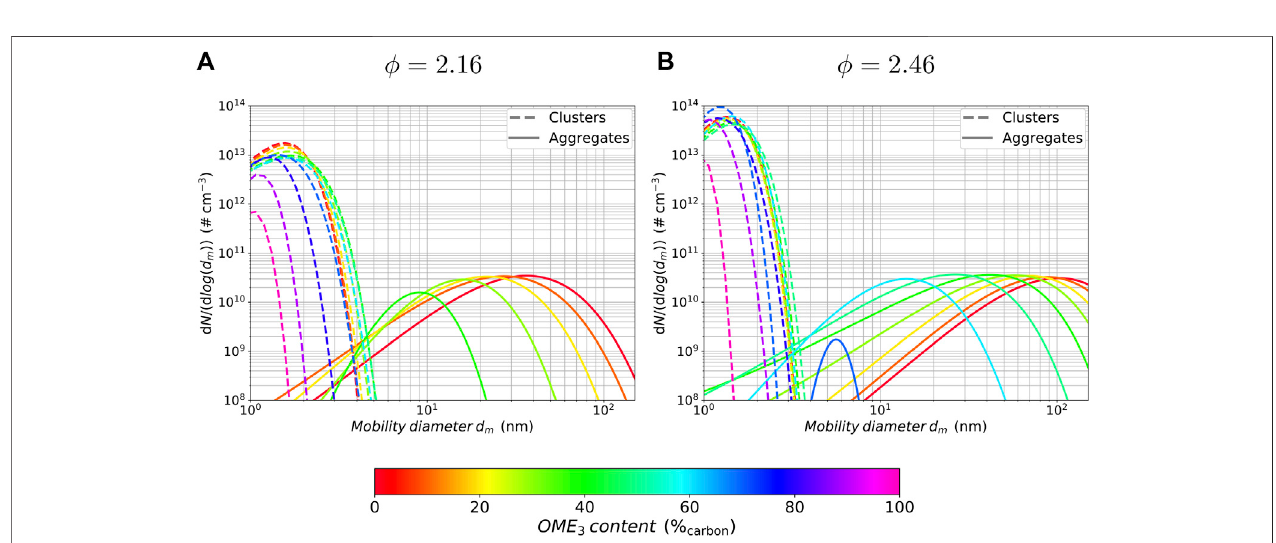
FIGURE7| Particlesizedistributionsofclustersandaggregatesata fl amepositionofHAB (cid:1) 20 mmfordifferentOME 3 blendingratiosandequivalenceratiosof ϕ (cid:1) 2.16 (A) and ϕ (cid:1) 2.46 (B) .